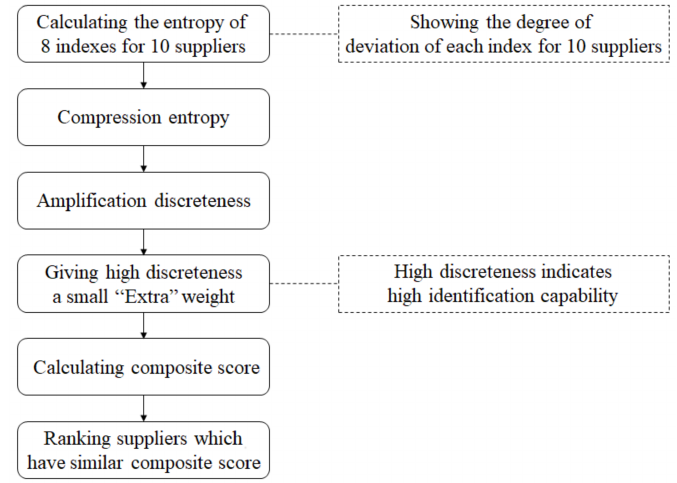
Figure 1. The flow chart of the Limited Diversity Factors Method